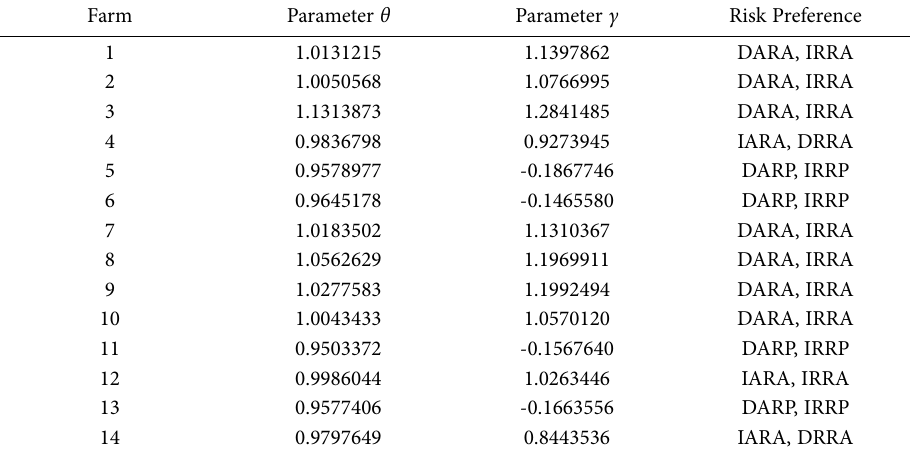
Table 7. Estimates of θ and γ